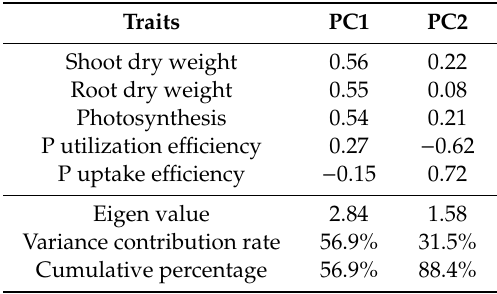
Table 12. Principal component analysis of morphophysiological traits under high and low nitrogen either from ammonium nitrate or nitrate.